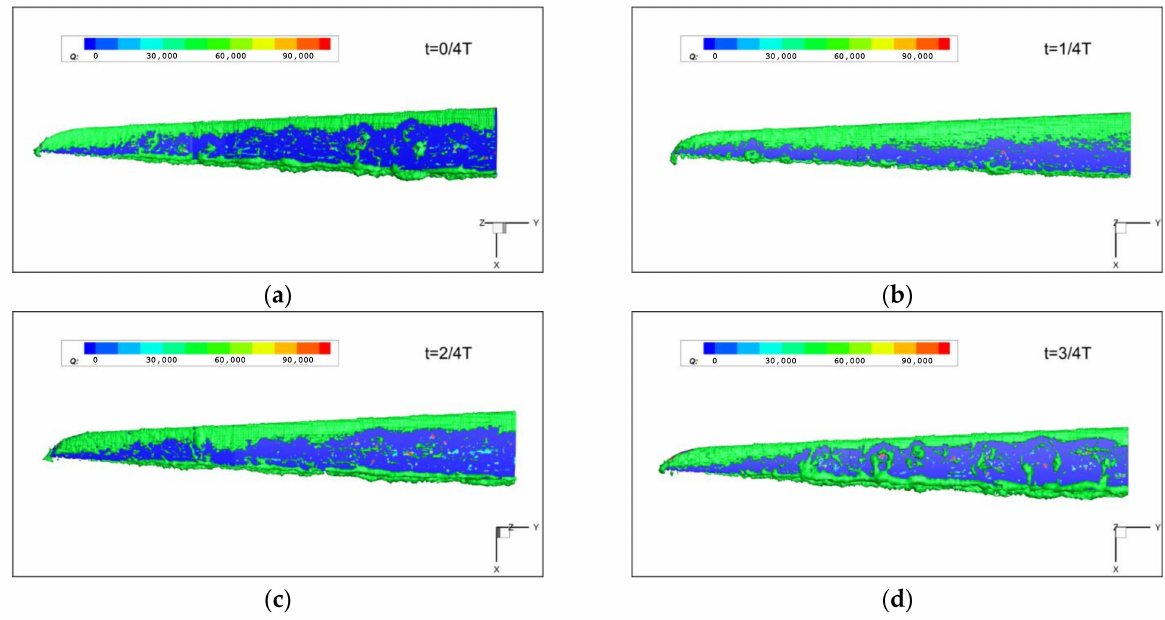
Figure 22. Q criterion of spanwise morphing wing at 10 ◦ AOA (Q = 50,000). ( a ) Time of 0/4 T, ( b ) time of 1/4 T, ( c ) time of 2/4 T and ( d ) time of 3/4